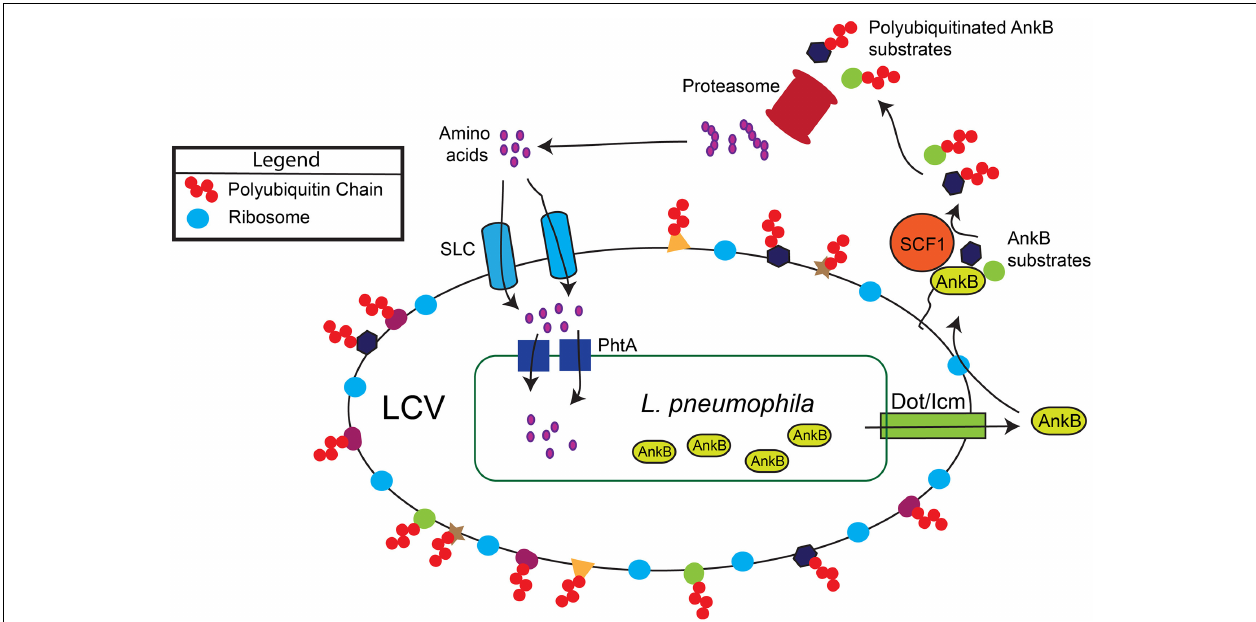
LCV that are subsequently degraded by the proteasome, which generates a surplus of cellular amino acids above the threshold necessary for intra-vacuolar proliferation. The amino acids are likely imported into the LCV through various host SLC amino acid transporters in the LCV membrane, but the identity of the transporters is still to be determined. The amino acids are acquired by L. pneumophila through numerous ABC transporters and amino acid permeases such as the threonine transporter